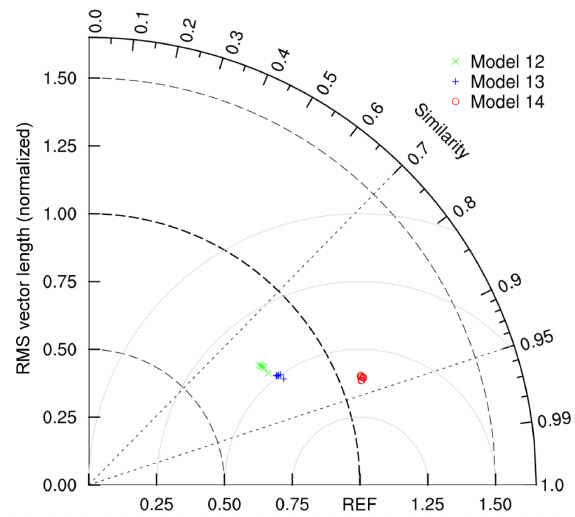
Figure 9. Normalized pattern statistics of climatological mean 850hPa vector winds in the Asian–Australian monsoon region (10 ◦ S–40 ◦ N, 40–140 ◦ E) among 19 CMIP5 models compared with the reanalysis data in summer (June–July–August). The climato- logical means were computed from the monthly data derived from CMIP5 historical simulations and reanalysis datasets during the pe- riod from 1979 to 2005, except for the ERA-40 reanalysis with a time span from 1979 to 2002. Each CMIP5 model was compared with six reanalysis data, respectively. The symbols with same type of mark and color represent the statistics of an individual CMIP5 model compared with various reanalysis